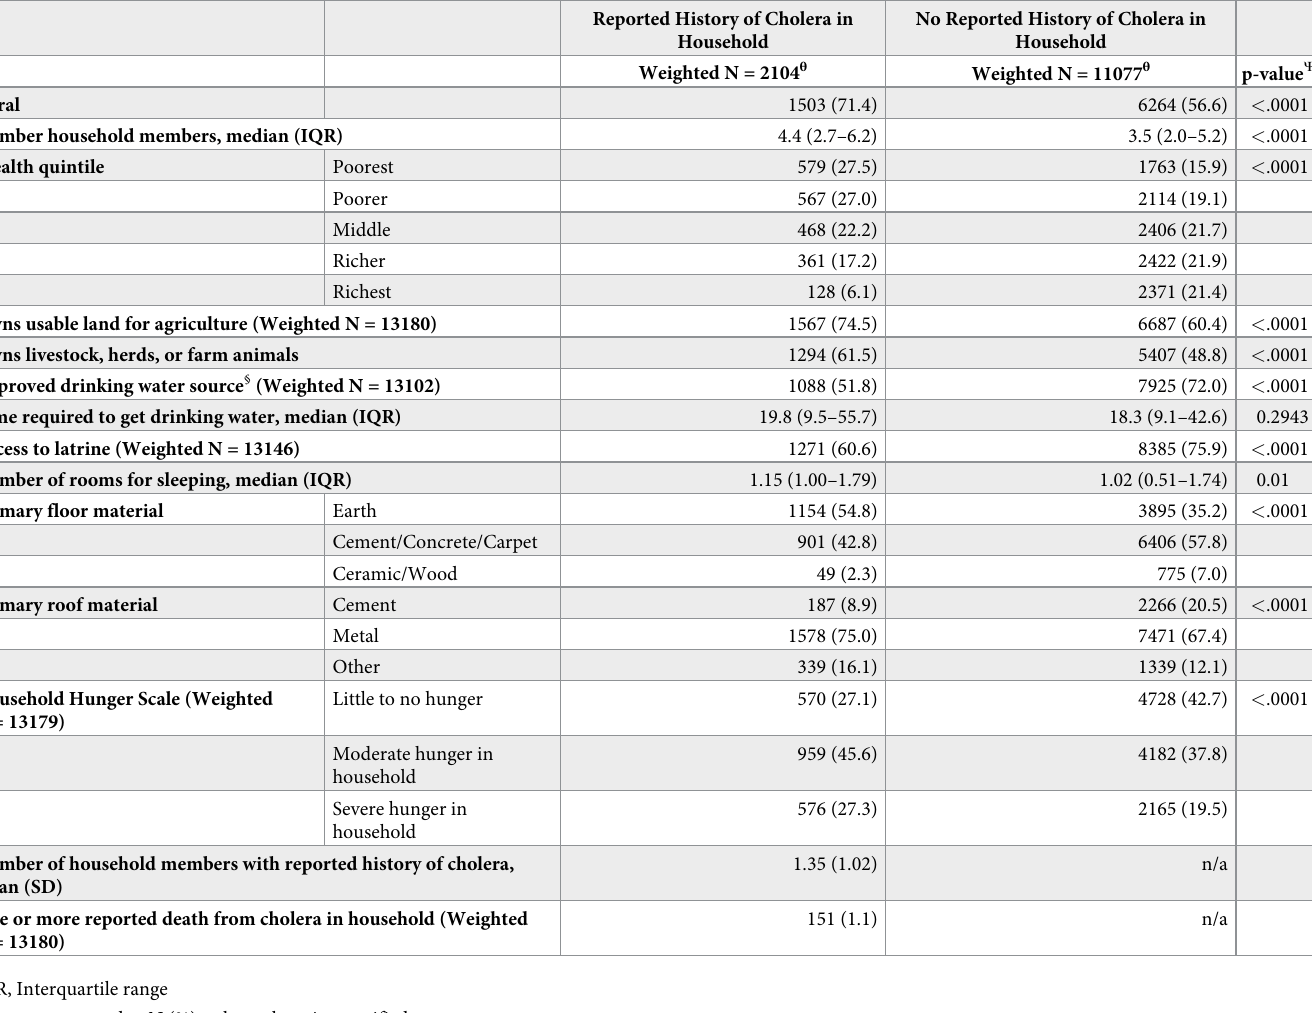
Table 2. Characteristics of households participating in the 2012 DHS in Haiti grouped by whether they reported at least one member with history of cholera since 2010 (N = 13,181 �